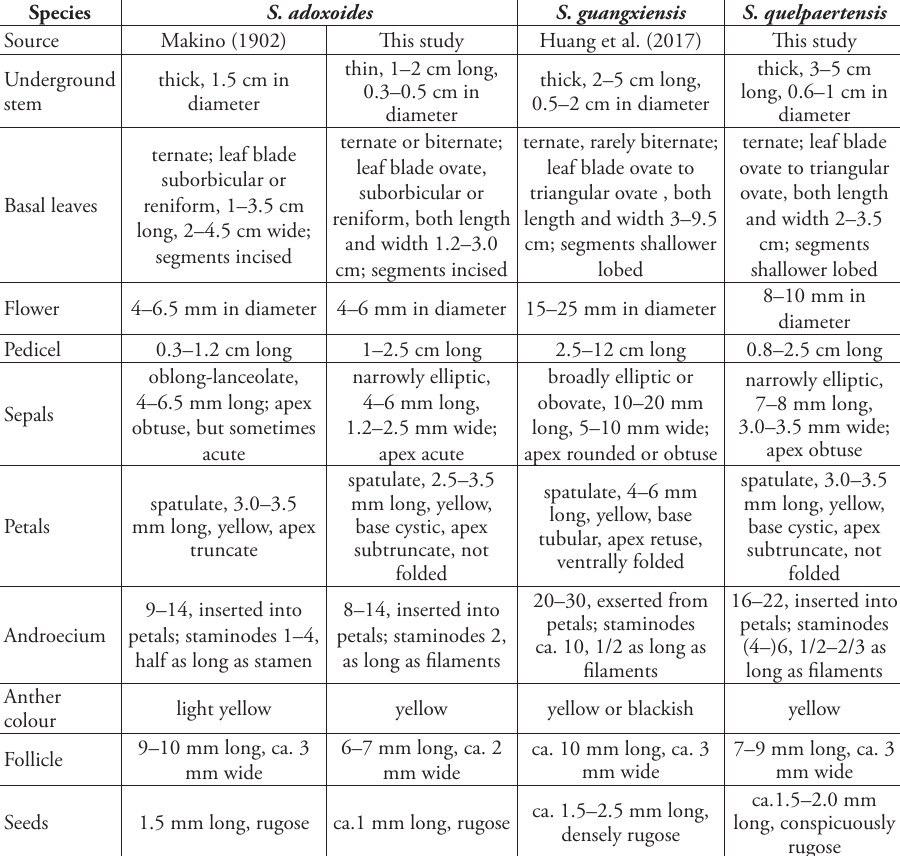
Table 1. Morphological data of Semiaquilegia spp.